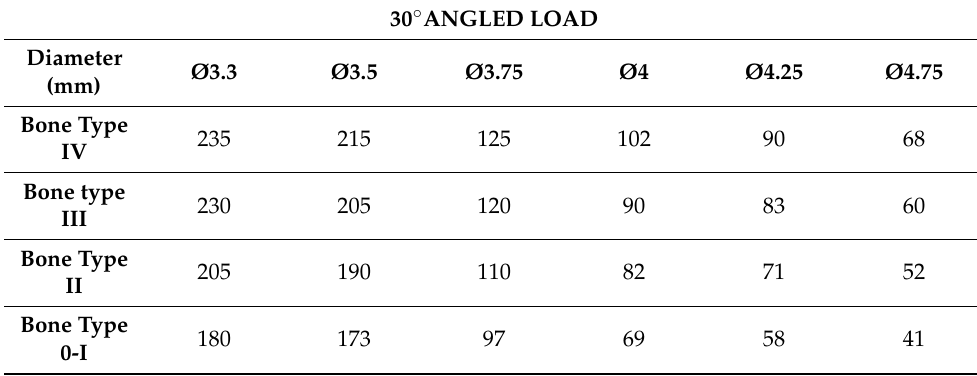
Table 2. Maximum equivalent Von Mises stress (MPa) in bone at an axial load of 200N.